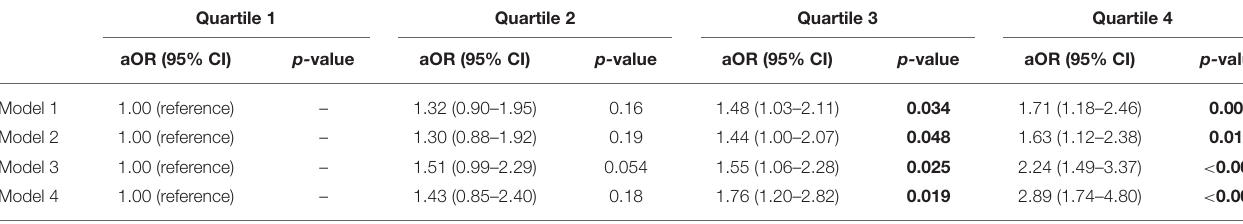
TABLE 3 | Odds ratio for cardiovascular events by quartiles of uric acid variability.